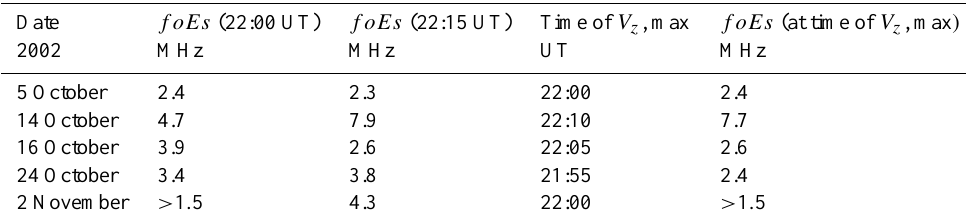
Table 2. f oEs values at Boa Vista / Campo Grande (the larger value) at the time of the prereversal enhancement on the days without ESF at Cachimbo.